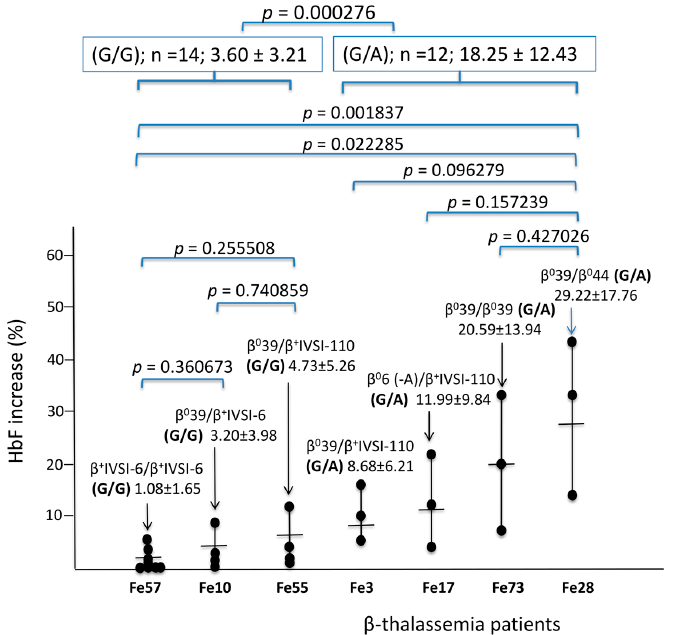
Figure 1. Heterogeneity in response to mithramycin (MTH) of ErPCs from different β -thalassemia patients recruited at Ferrara Hospital and accordingly labeled with “Fe”. The different dots represent independent MTH treatments on ErPCs isolated from the same patients at different times (at least three blood sampling for each of the indicated patients were performed at different times). ANOVA was used to test differences in the percent of HbF increase among genotypes; a post hoc LSD test was used, and the p values are indicated in each panel. “n” identifies the number of patients recruited. When more than one induction experiment was performed, each dot represents the average of the percent of HbF